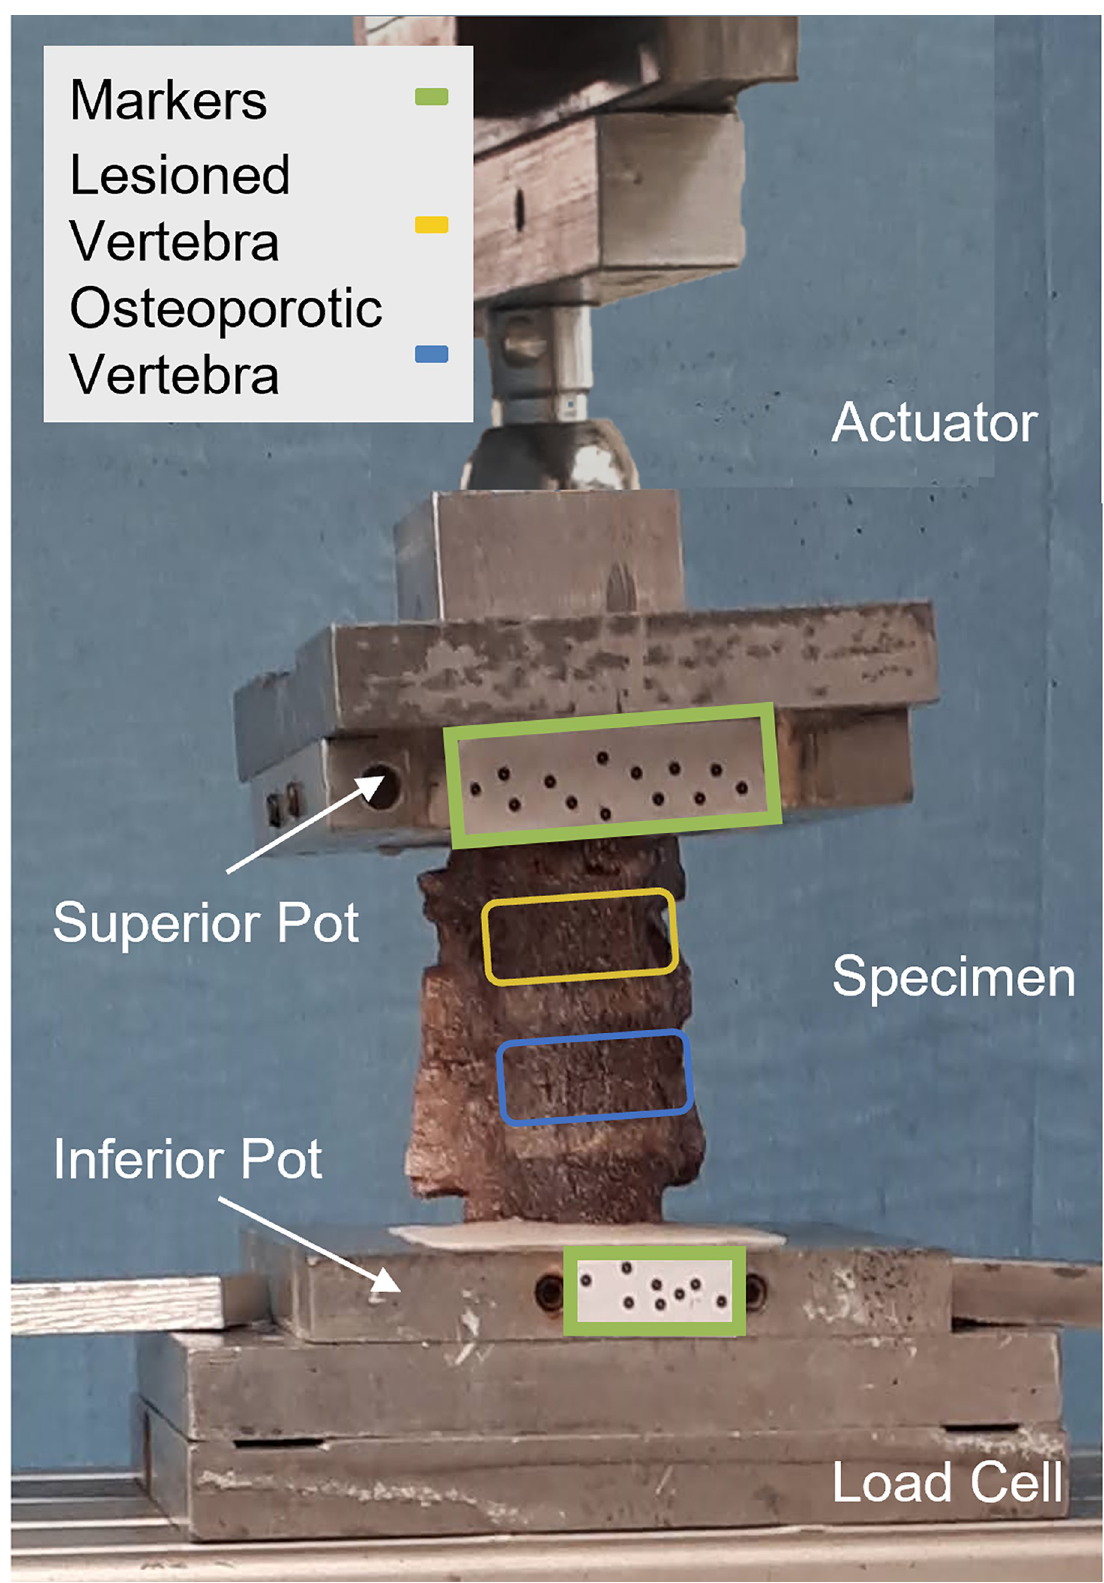
Fig 1. Experimental set up. Specimen mounted on the testing machine with the set up in the compression-flexion configuration. https://doi.org/10.1371/journal.pone.0272529.g001 PLOS ONE | https://doi.org/10.1371/journal.pone.0272529 September 9,